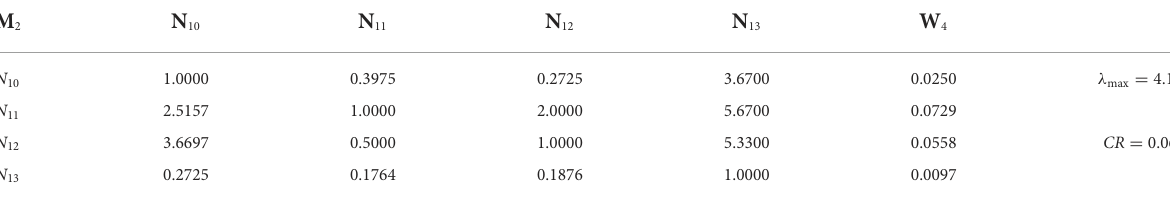
TABLE 7 Consistency ratio of judgment matrix of feedback mode criteria and its weights.